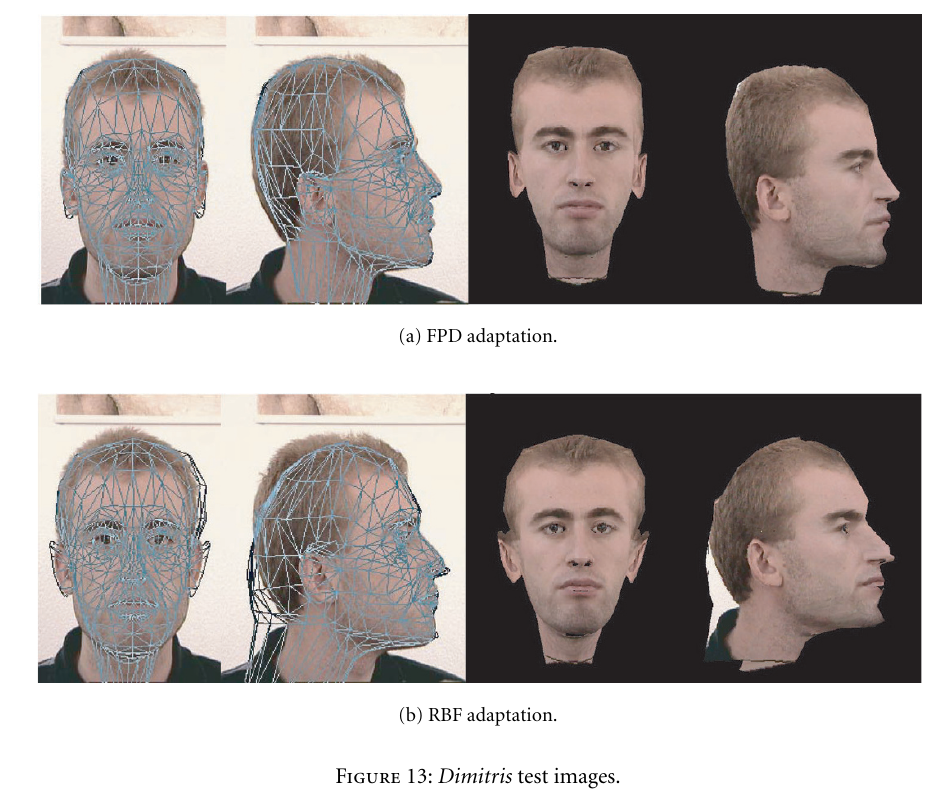
Figure 13: Dimitris test images.